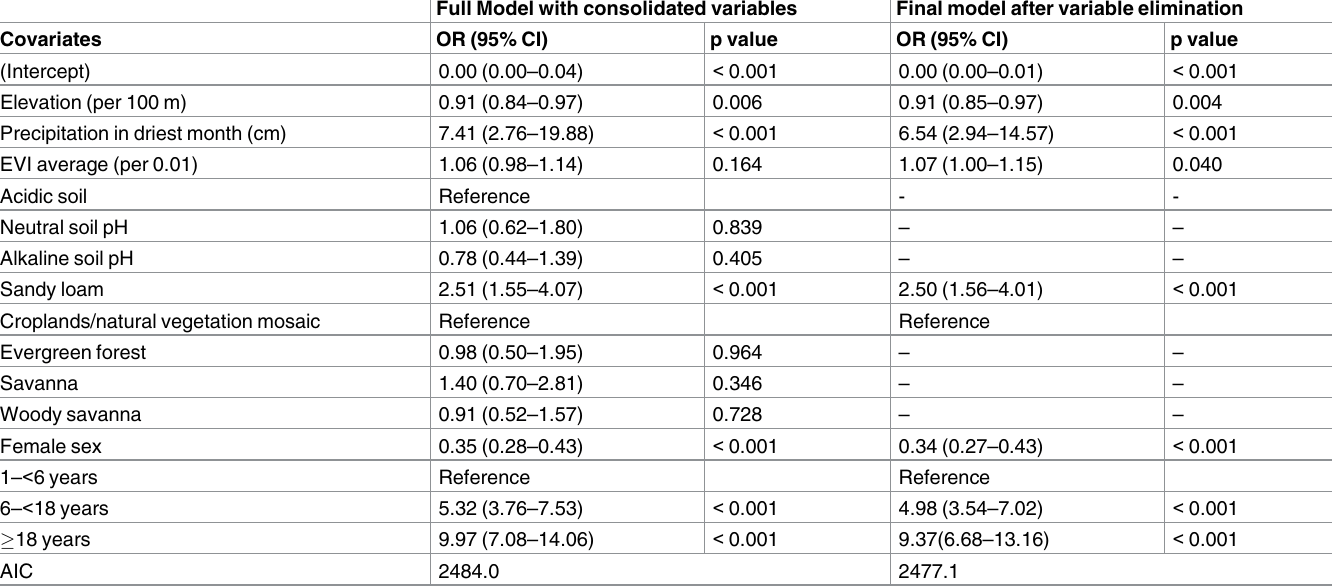
Table 4. Multivariable associations between environmental and demographic factors and the likelihood of N . americanus infection, using multi- level mixed-effects logistic regression (n =